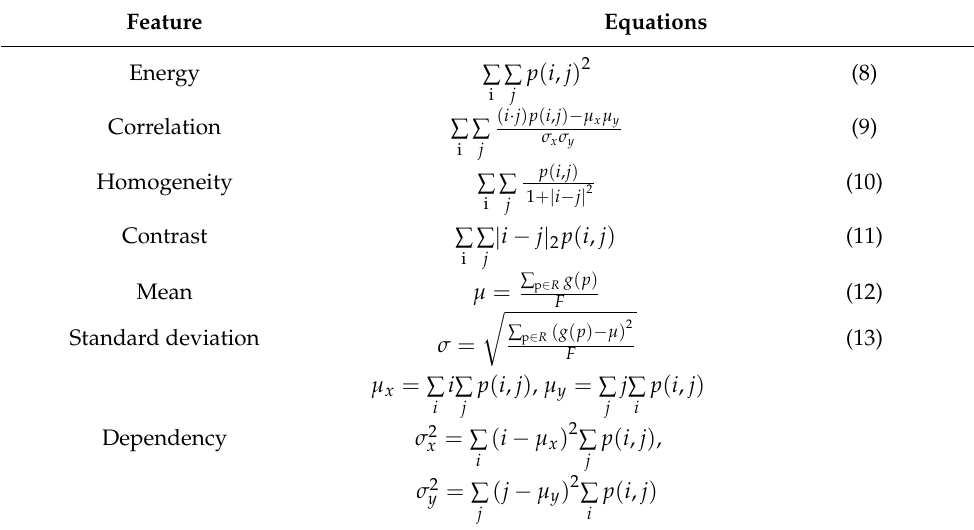
Table 4. GLCM-based texture features.